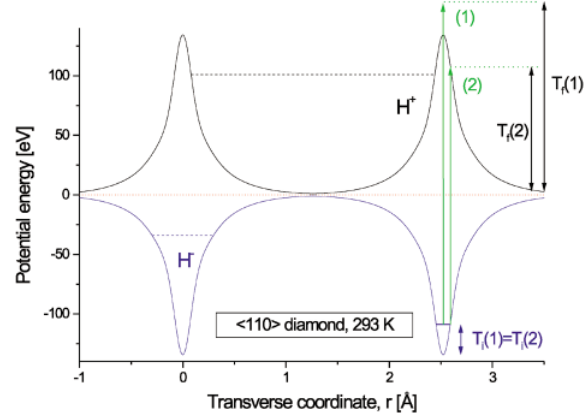
FIG. 2. (Color) The (cid:5) 110 (cid:6) axial potential in diamond, calculated from the Doyle-Turner model at 293 K. The upper curve rep- resents the potential energy for protons, while the lower is for H 2 . For both cases, the region accessible to a particle with T (cid:1) (cid:1) 100 eV is shown as a horizontal dashed line. On the right, (1) and (2) denote stripping processes, where the potential “flips”; see text for details.